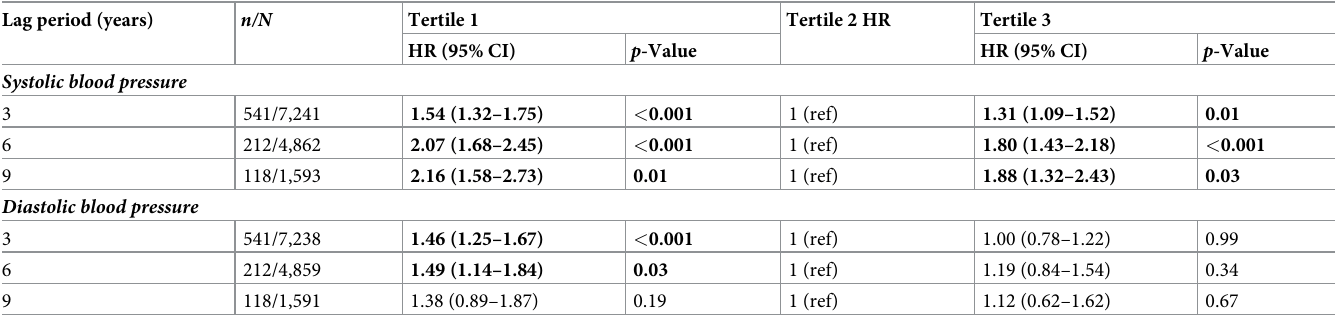
Table 5. Association between rise and fall of blood pressure and incident any stroke using different lag